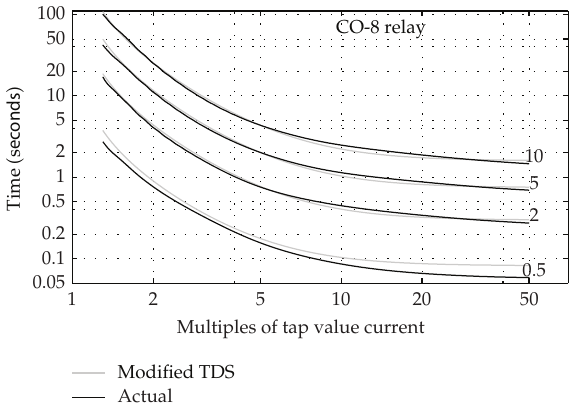
Figure 2: The actual characteristic curves and the modified curves fitted by (cid:3) 2.6 (cid:4) for the CO-8 relay.